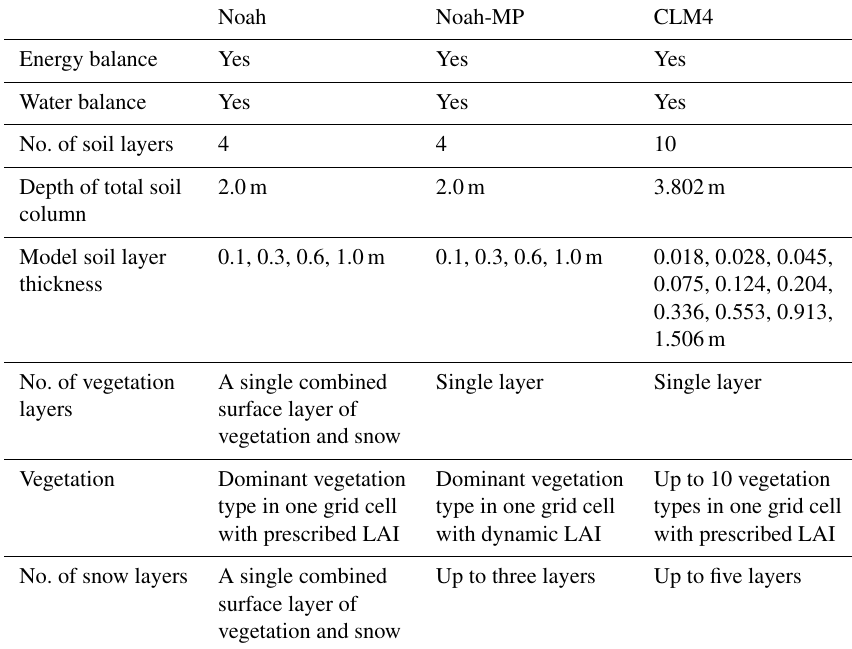
Table 1. Comparison of Noah, Noah-MP, and CLM4.